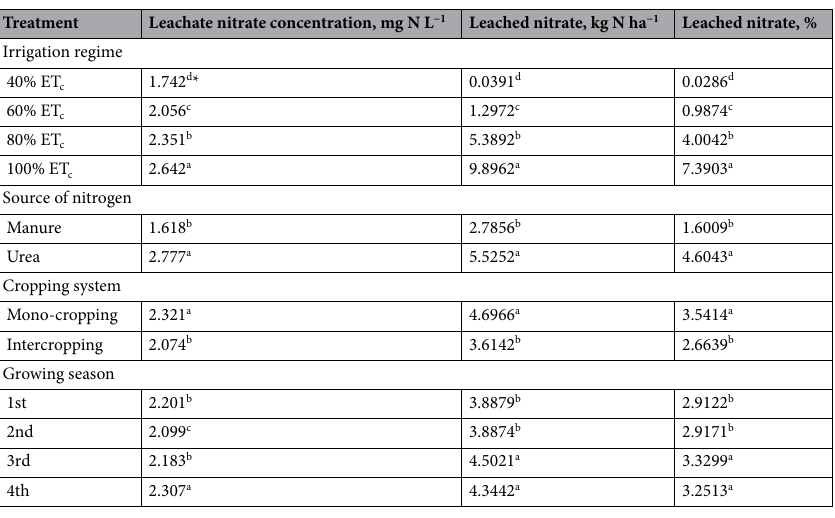
Table 3. Means for average seasonal nitrate concentration in drainage water, seasonal cumulative leached nitrate, and seasonal leached nitrogen as a percentage of total available nitrogen in the applied fertilizer (urea or manure). *Means followed by similar letters in each column for each factor are not significantly different at 5% level of probability according to Tukey test.